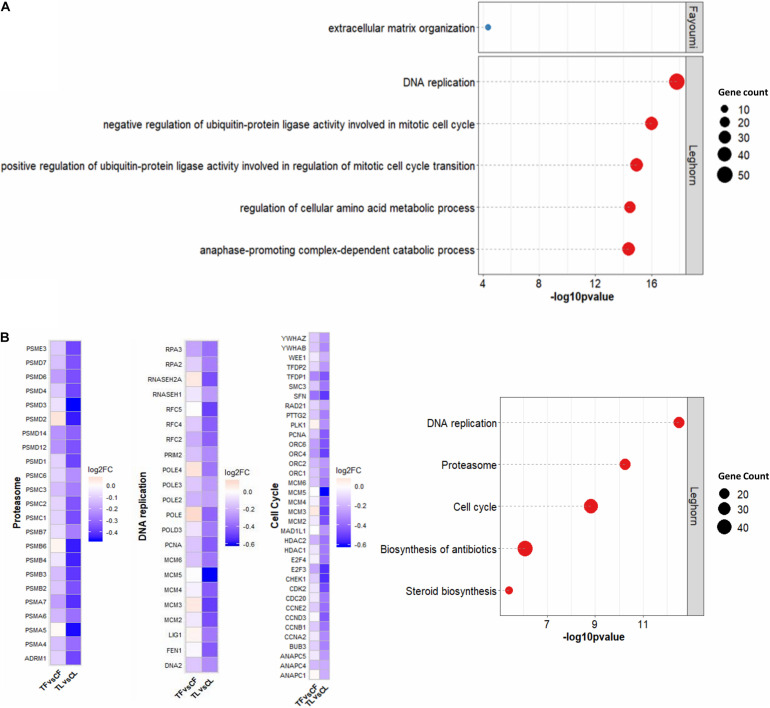
Functional analysis of DEGs for within-line comparisons. (A) Top 5 GO terms for biological processes. (B) Top 5 KEGG pathways on the right were found for Leghorn only and heat map of the log2 fold changes of the DEGs within the top 3 KEGG pathways related to cell proliferation on the left. The number of genes denotes the number of DEGs associated with the term or pathway. Significant GO terms and KEGG pathway were identified by p < 0.05 with more than two gene counts. CF, control Fayoumi; TF, treated Fayoumi; CL, control Leghorn; TL, treated.